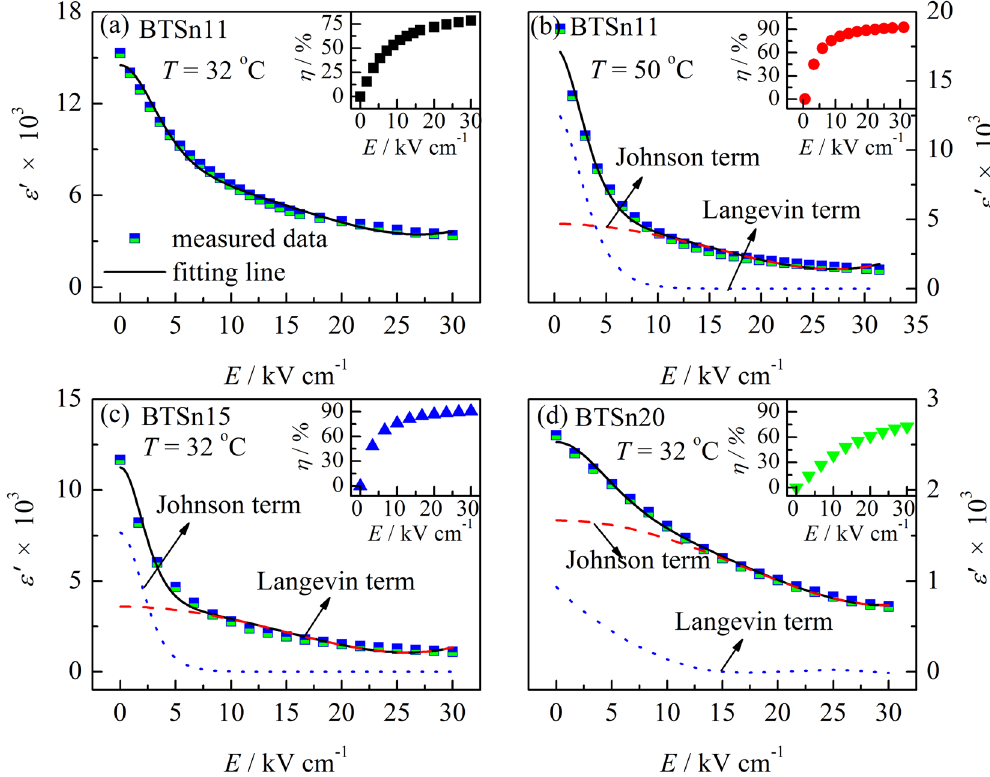
Figure 3. ( a–d ) Dielectric permittivity as a function of dc electric field of BTSn11, BTSn15 and BTSn20 from bias electric field measurement taken at 10 kHz and at the temperature of 32 °C and 50 °C. The data of BTSn11 measured at 32 °C were fitted by Eq. (3); the data of BTSn11 measured at 50 °C, BTSn15 and BTSn20 were fitted by Eq. (4); and Johnson term and Langevin term were simulated by the fitting parameters. The insets in ( a – d ) are dielectric tunability of BTSn11, BTSn15 and BTSn 20 as a function of the electric field.